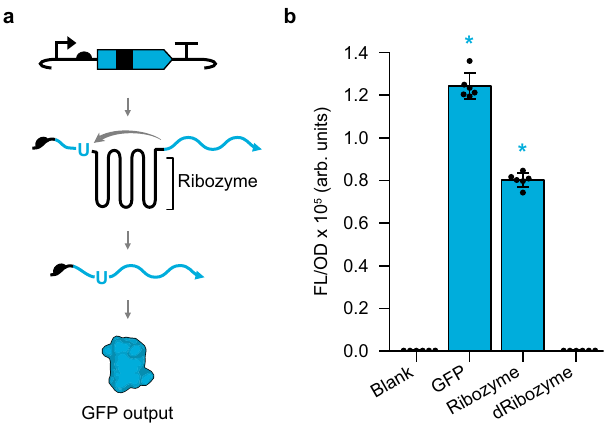
Fig. 1 | Fluorescence splicing assay enables convenient measurement of ribo- zyme splicing activity. a Splicing assay utilizes a plasmid containing an sfGFP coding sequence (blue) with the Tetrahymena thermophila ribozyme DNA sequence (black) inserted within codon Y66. When this DNA is transcribed into RNA, the ribozyme splices together the sfGFP exons at the 5 ’ splice site (blue U), located just upstream of the ribozyme, and the spliced product is translated into the native sfGFP (GFP output). b Fluorescence characterization (measured in units of fl uorescence [FL]/optical density [OD] at 600nm) performed in E. coli trans- formedwithanemptyplasmid(Blank),aplasmidcontainingsfGFP(GFP),aplasmid containing sfGFP with an inserted wild-type ribozyme (Ribozyme), and a plasmid containing sfGFP with an inserted catalytically dead G264A mutant ribozyme (dRibozyme). Bars show mean values and error bars represent s.d. of n =6 biolo- gical replicates shown as points. To determine signi fi cance, a two-tailed t-test (alpha=0.05)resultedin p -valuesof 2.6e − 13,5.5e − 14,and 0.86forGFP,Ribozyme, and dRibozyme relative to Blank, respectively. Statistically signi fi cant differences ( p <0.05)areindicated byasterisksabovebars.Sourcedatafor( b )areprovidedas a Source Data fi